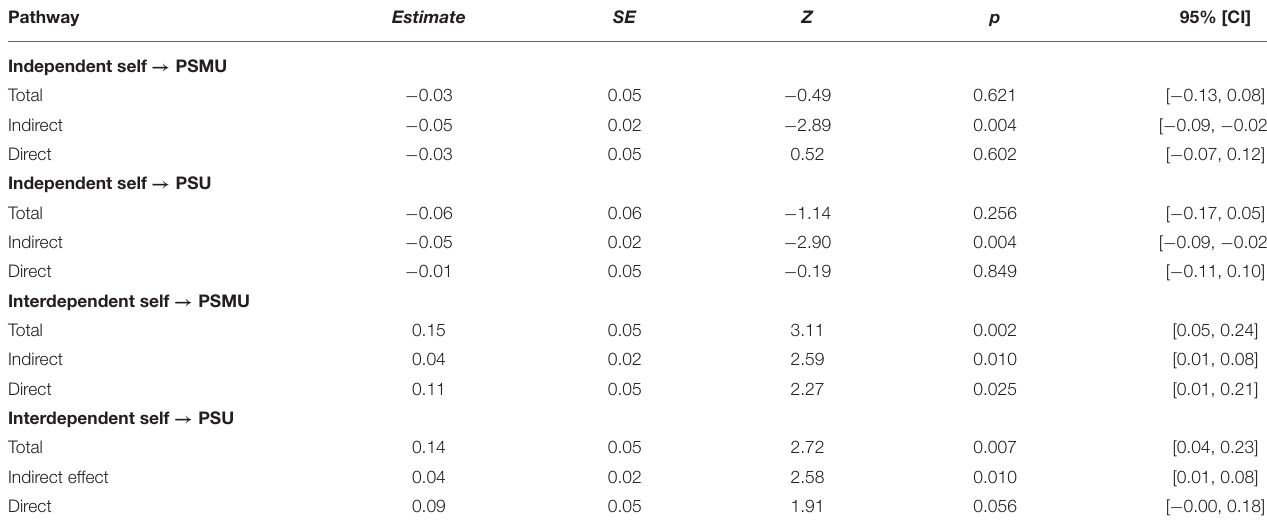
TABLE 2 | Mediation and indirect effects with standardized estimates of FoMO for the relationship among self-construal (independent self and interdependent self), PSMU, and PSU. Pathway Estimate